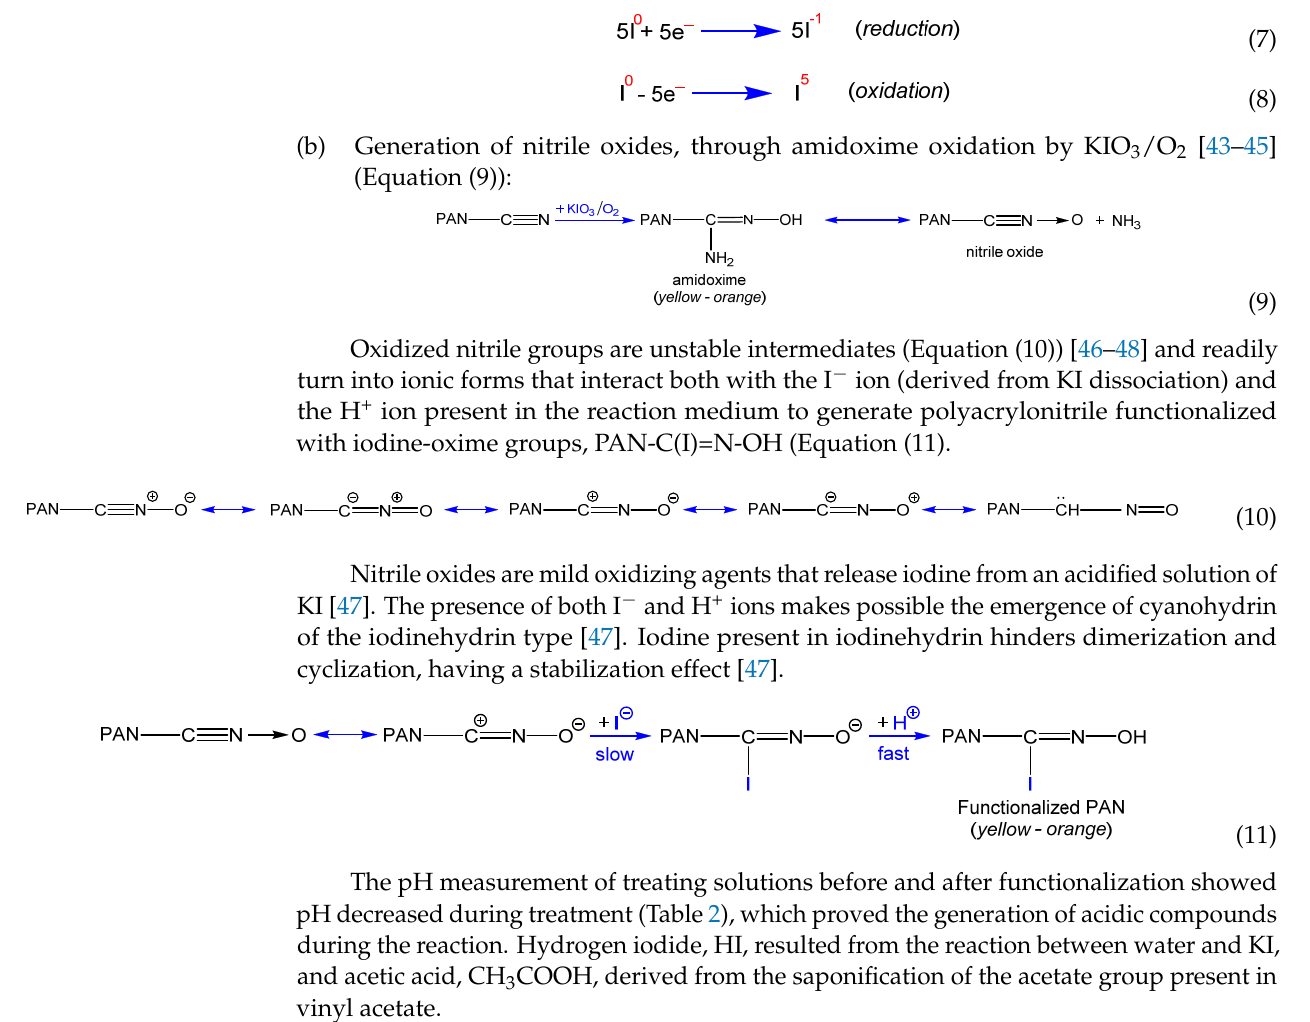
group present in vinyl acetate.